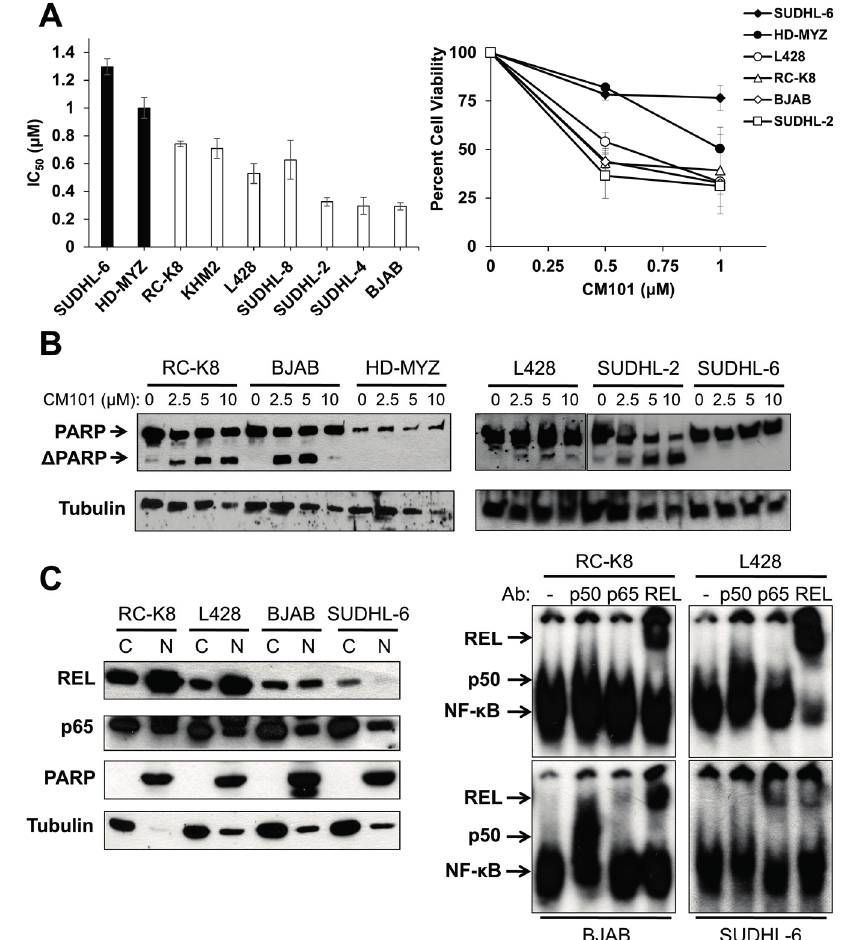
Figure 3. Sensitivity of human B-lymphoma cell lines to CM101 is correlated with active REL nuclear complexes. ( A ) A panel of B-lymphoma cell lines were seeded in triplicate at a cell number of 10 5 . Approximately 18 h later, cells were treated with increasing concentrations of CM101, incubated for an additional 72 h and cells were then counted. Cell numbers are relative to methanol-treated control cells (left panel). IC 50 values were calculated by plotting the relative cell numbers at each concentration of CM101, which were normalized to cells incubated with no CM101 (100%) (see Figure S2A for the graph that was used to calculate IC 50 values). Error bars indicate standard error. Right panel, MTT assays were performed and cell numbers were normalized to methanol-treated control cells; ( B ) The indicated B-lymphoma cell lines treated with various concentrations of CM101 for 24 h and cell extracts were analyzed for PARP cleavage by western blotting. The full-length and cleaved PARP ( Δ PARP) bands are indicated. β -Tubulin western blotting was performed as a loading control; ( C ) Nuclear levels of REL were assessed from cytosolic and nuclear extracts prepared from RC-K8, L428, BJAB and SUDHL-6 cells. Extracts were analyzed by western blotting for REL and p65 (left panel). PARP and β -tubulin western blotting was performed to assess the purity of the nuclear and cytoplasmic fractions, respectively. EMSAs were performed on nuclear extracts with no antibody or antibodies for p50, p65 or REL for supershift analyses (right